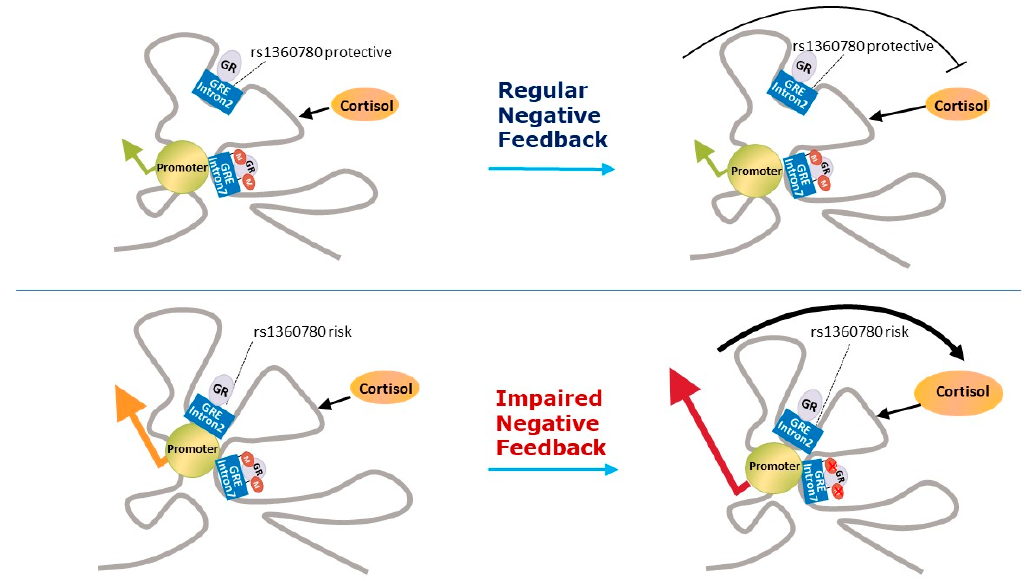
Figure 2. Representation of the epigenetic modification in FKBP5 . The single-nucleotide polymorphism rs1360780 which is close to a functional GRE in intron 2 constitutes the genetic predisposition for an increased FKBP5 transcriptional response to stress. Demethylation with higher cortisol levels is possibly restricted to certain developmental periods (e.g., childhood). The exposure to childhood trauma leads to an increased activation of FKBP5 due to a reduction in DNA methylation in SNP risk allele carriers. Adapted by permission from [Nature]